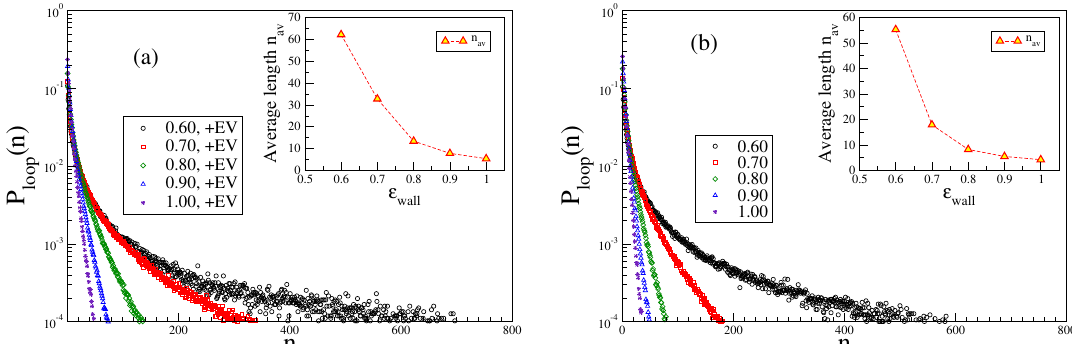
Figure 11. Probability distribution P loop ( n ) to observe loops having a length of n monomers, for N = 750 and two choices of κ , κ = 5 ( a ); and κ = 8 ( b ). Five choices of (cid:101) wall are included, as indicated. In case ( b ), symbols indicate data with EV shut off while curves show data including EV. (cid:82) dnP loop ( n ) n . Insets show the average loop length, defined as n av =